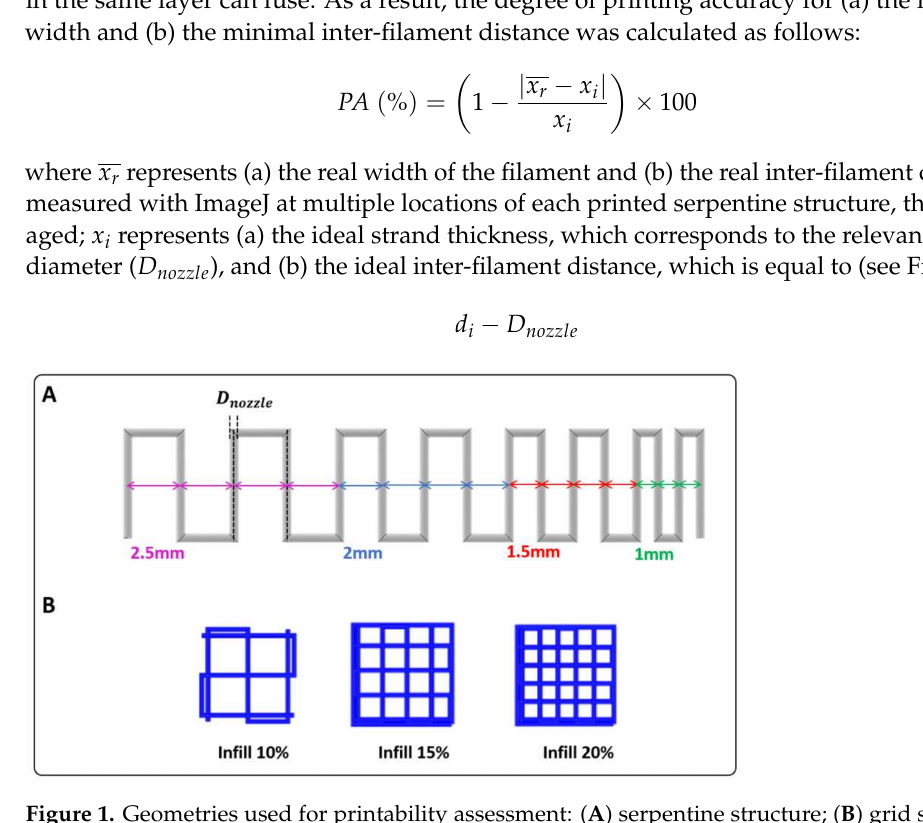
Figure 1. Geometries used for printability assessment: ( A ) serpentine structure; ( B ) grid structure with 10%, 15%, and 20%